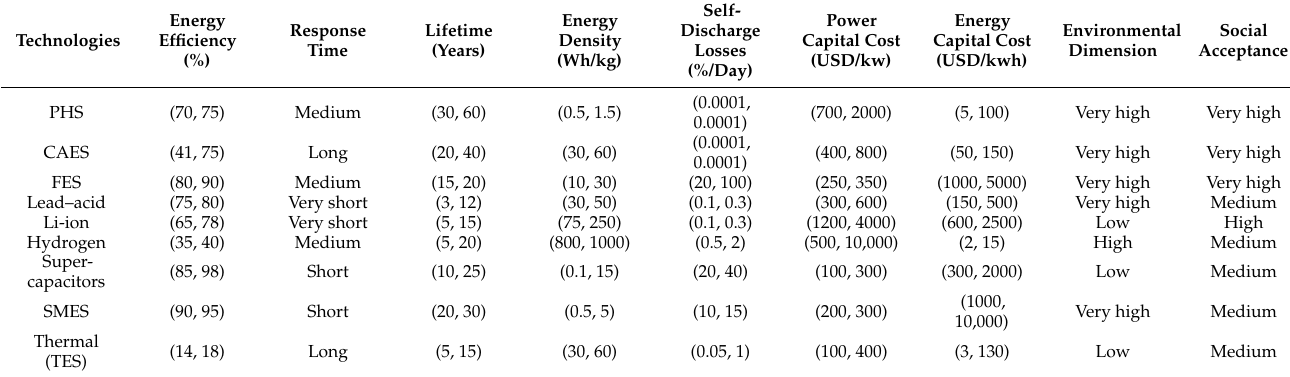
Table A3. Decision basic data of Expert 3.